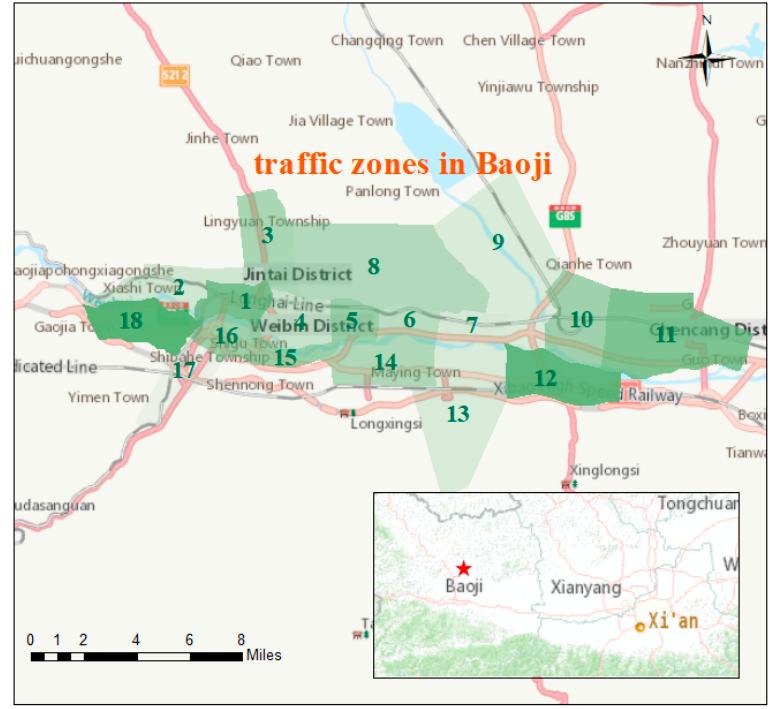
Figure 1. Division of Baoji traffic zones.